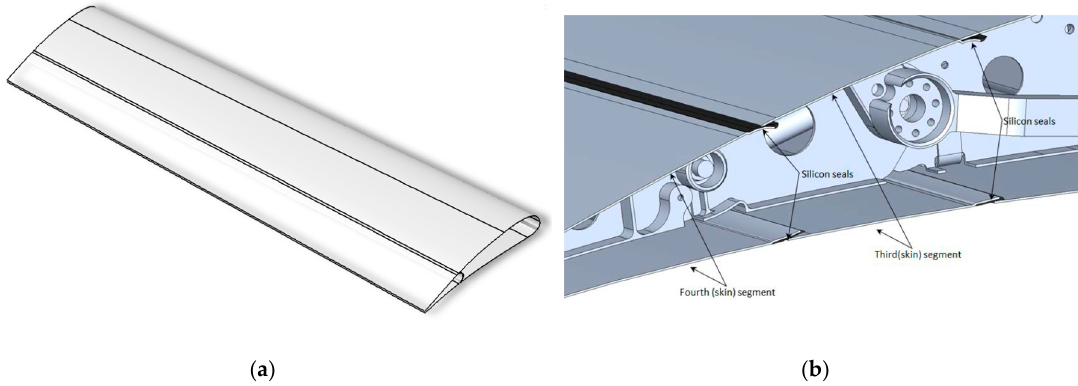
Figure 6. Morphing flap skin arrangement: global architecture ( a ) and detail of sliding parts ( b ).